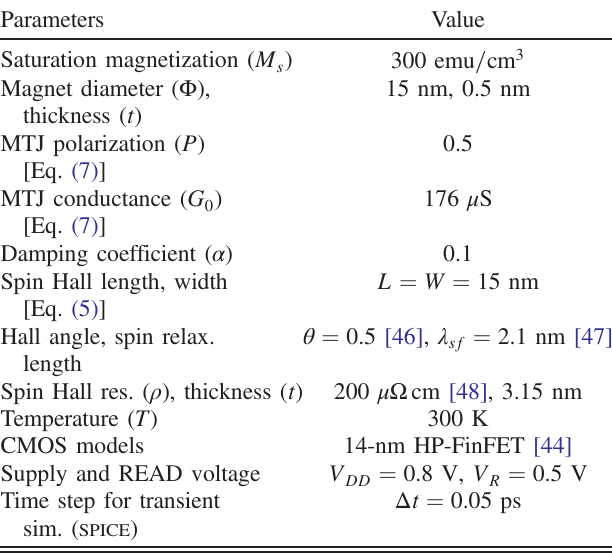
TABLE I. Parameters used for simulations in Figs. 3 and